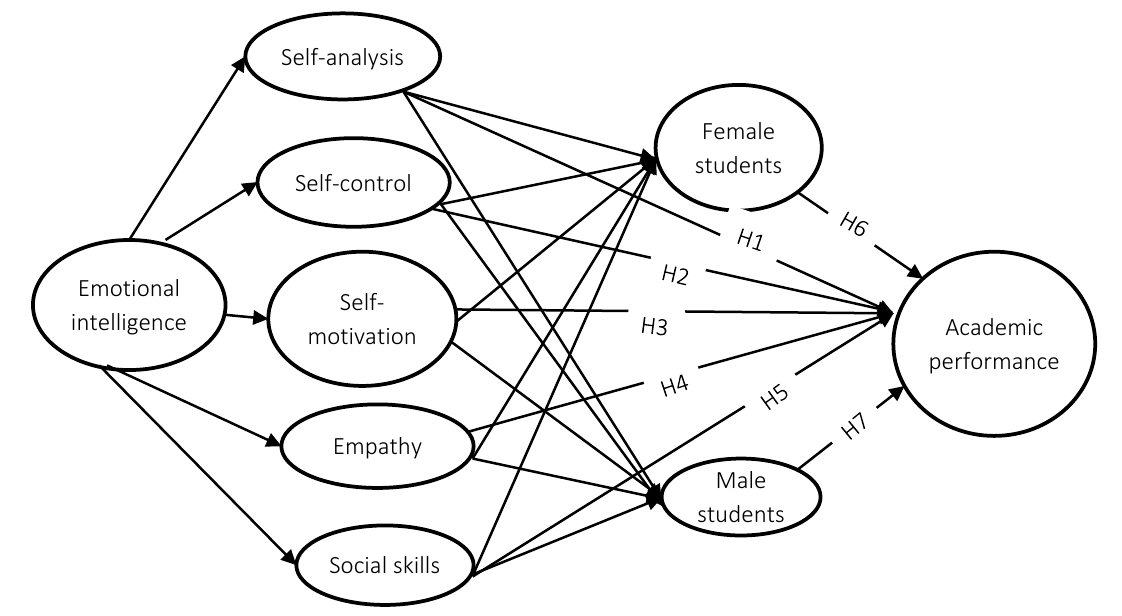
Figure 1. Conceptual framework of EI components and academic